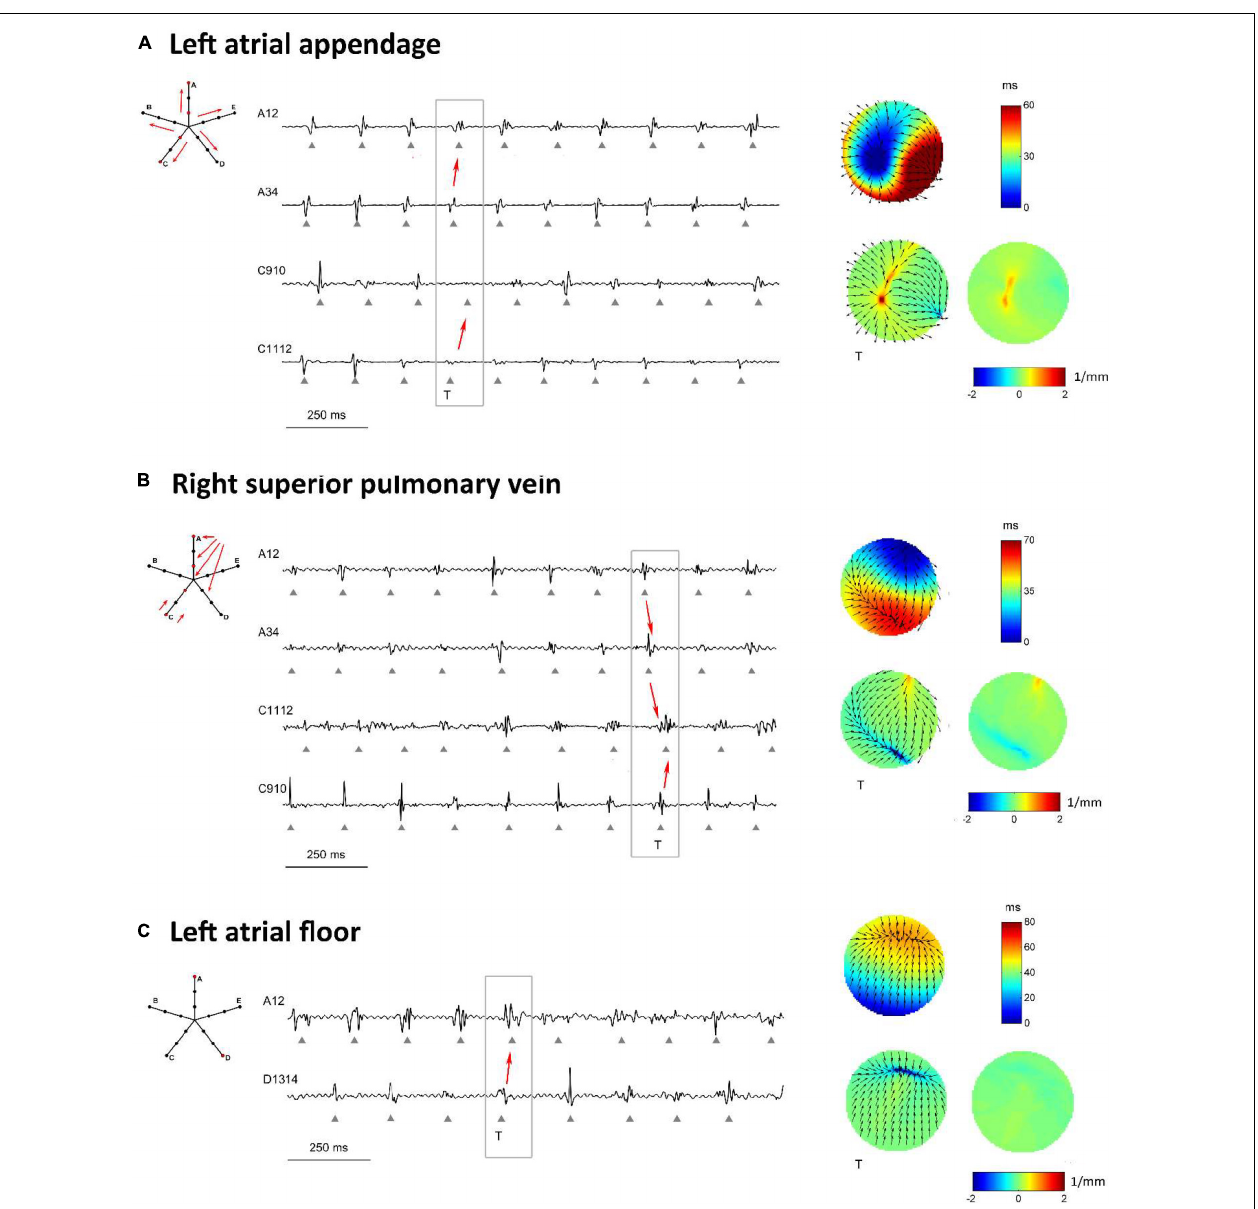
FIGURE 8 | Proof-of-concept application of divergence analysis to multipolar electrograms acquired during left atrial mapping in an AF patient. The displayed multipolar mapping data were collected at the left atrial appendage (A) , PVs region (B) , and left atrial floor (C) . For each mapped region, the left panels show a schematic representation of the multipolar mapping system with arrows indicating the prevalent activation sequence and the representative electrograms corresponding to the red bipoles of the catheter. The right panels show single-beat reconstructed activation and divergence maps for the evidenced beat and the average divergence map calculated over the analyzed